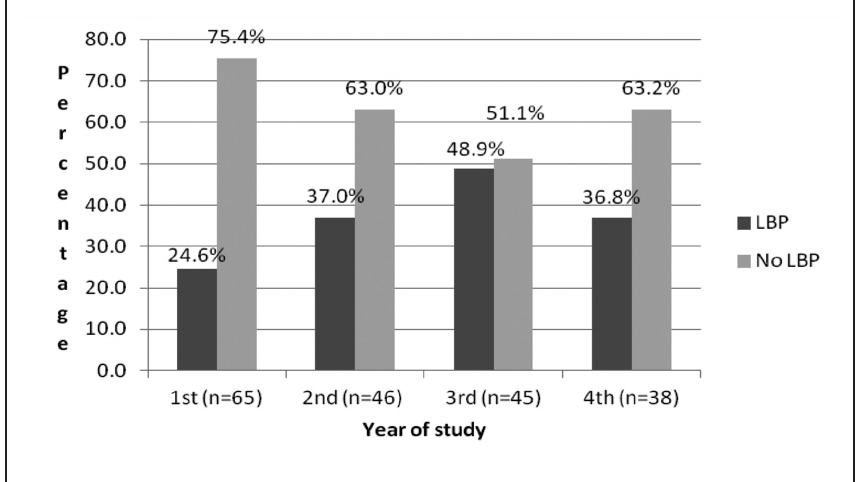
Figure 5: Prevalence of Low Back Pain by Year of Study (n=194)